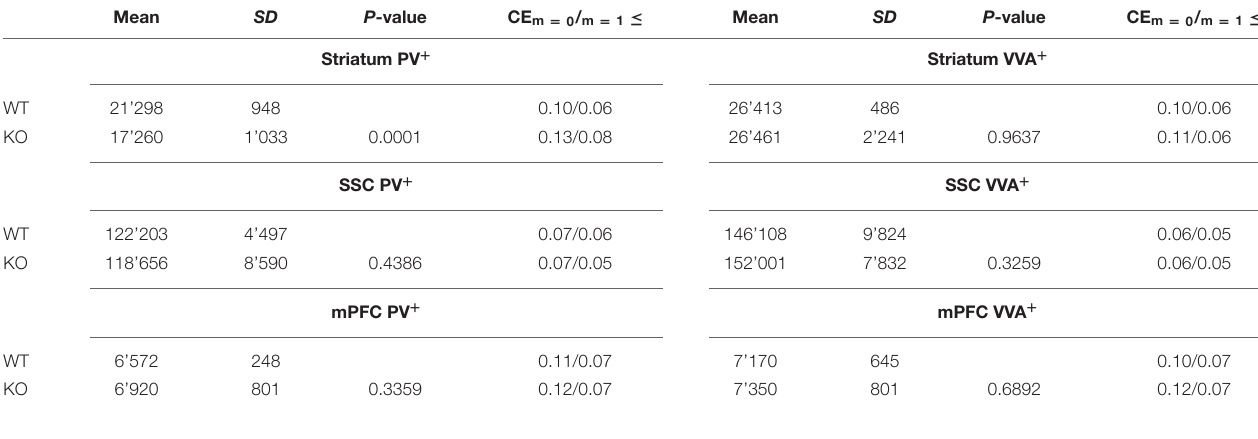
TABLE 2 | Mean total number of PV + and VVA + cells in the striatum, SSC and mPFC of WT and Cntnap2 − / − mice.